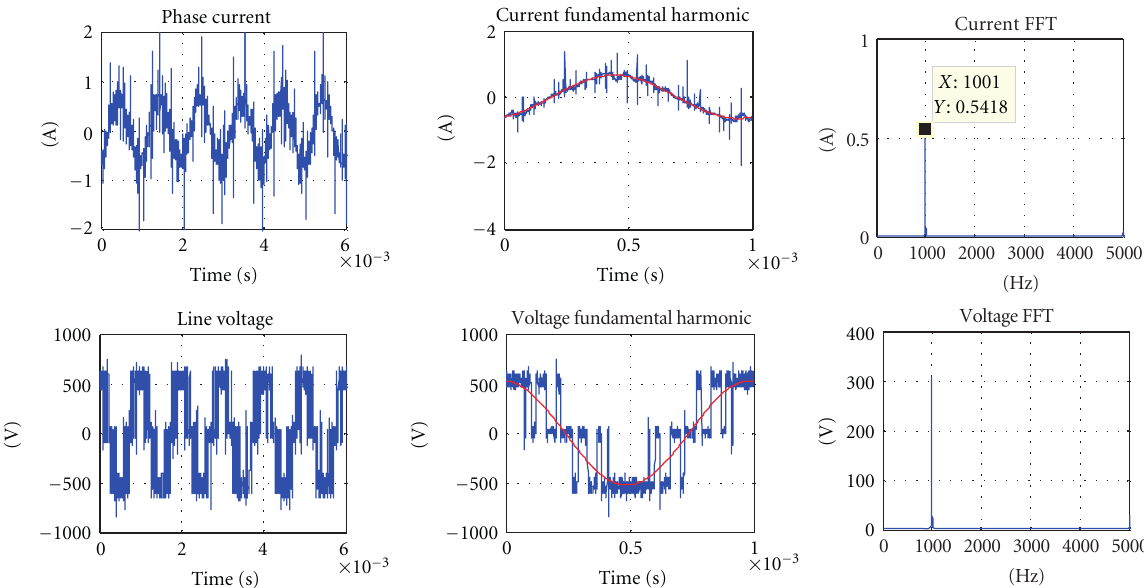
F 11: Experimental results and the FFT analysis of the stator current/voltage waveforms at 60000 rpm under full-load condition.